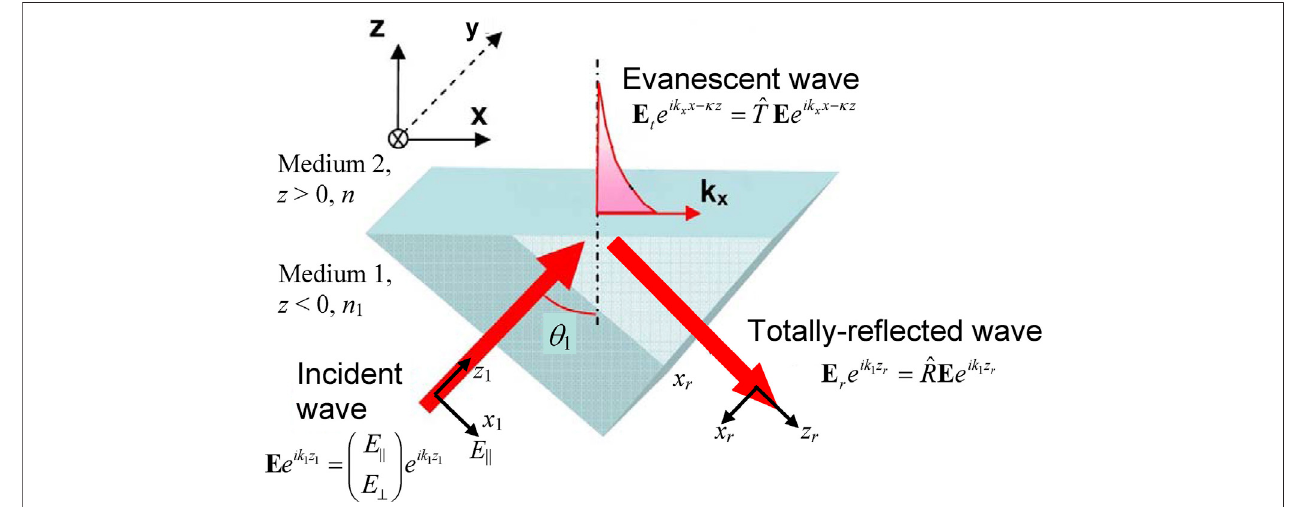
FIGURE 6 | Illustration of the evanescent wave formation (explanations in the